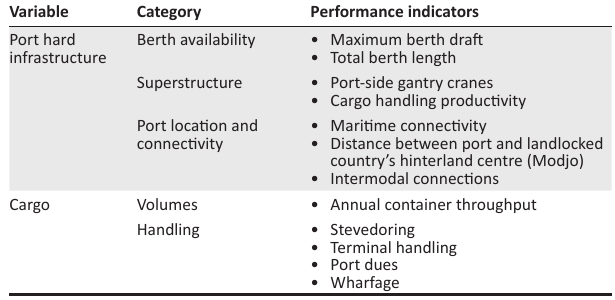
TABLE 2: Criteria for evaluating transit corridors.